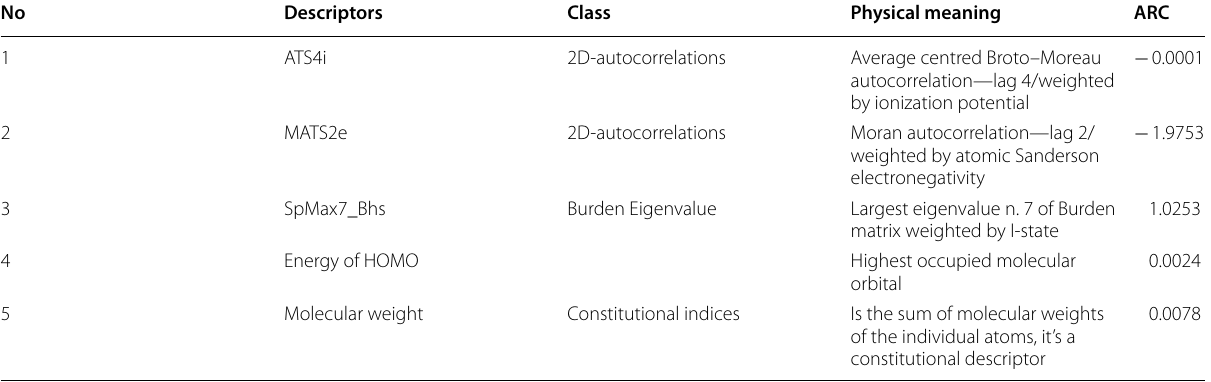
Table 6 Molecular descriptor and their regression coefficient